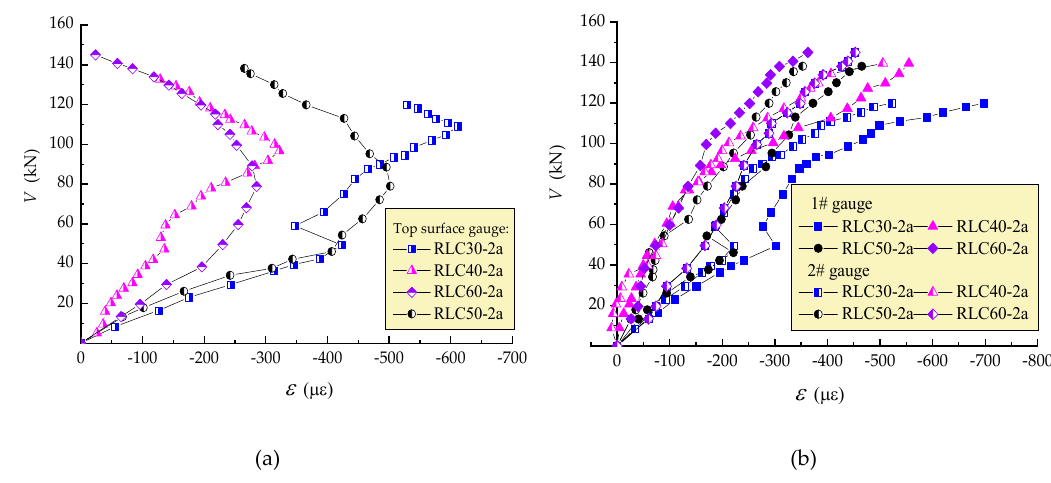
Figure 6. Concrete strain in compression ‐ shear region of test beams with different strength of CRAC: ( a ) top surface gauge; ( b ) 1# and 2# gauges on side surface. Materials 2020 , 13 , x FOR PEER REVIEW